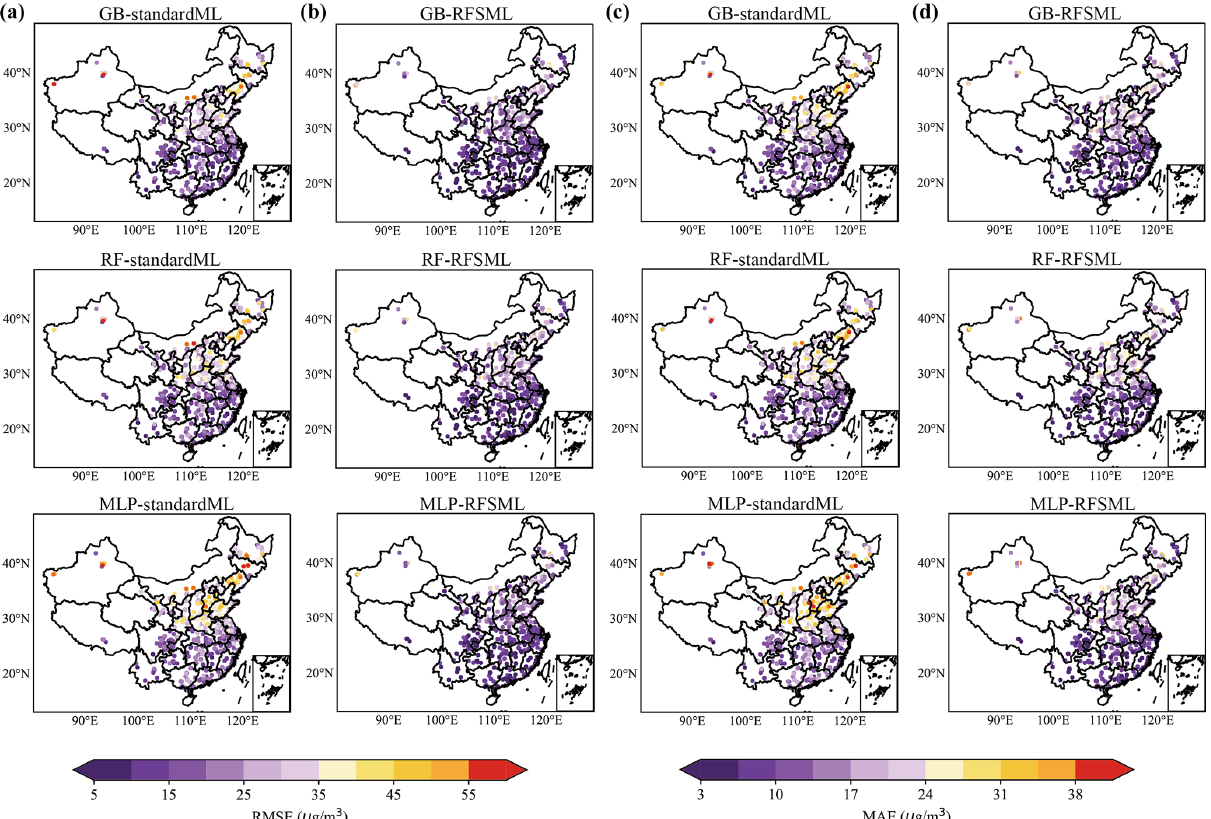
Figure 7. Spatial distribution of RMSEs and MAEs at a prediction horizon of 12h. Panels (a) and (c) are results of standard machine learning system, while panels (b) and (d) are results of RFSML. The cooler the color tone, the lower the RMSEs and MAEs and thus the better the prediction